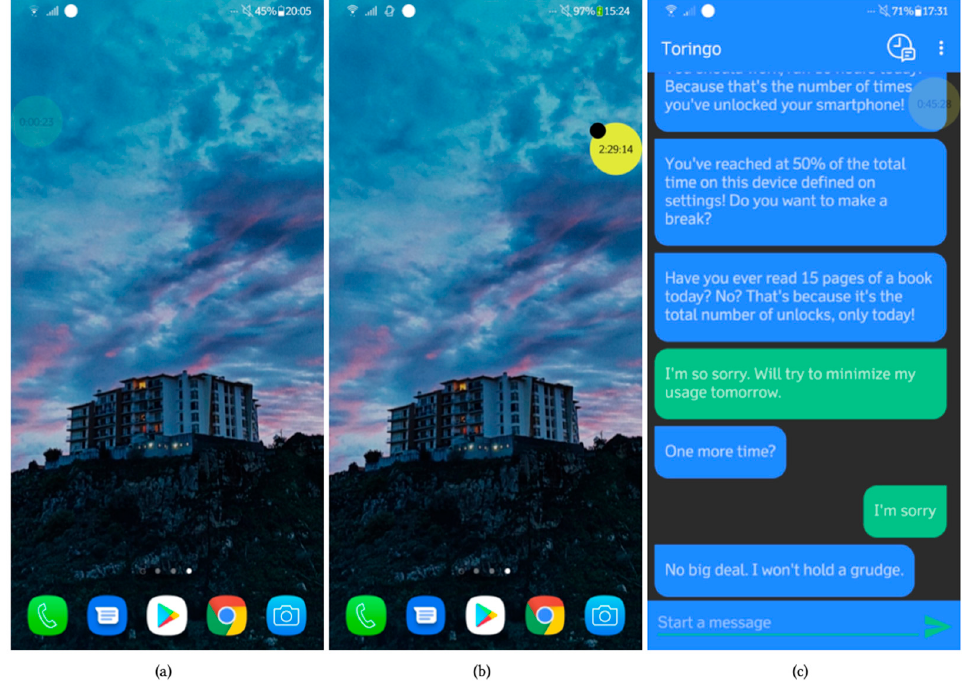
Figure 2. A floating widget that shows the user ( a ) the total time on screen (less than 50% of the defined goal), ( b ) the total time on screen (more than 50% of the defined goal) and with a pending message from the conversational agent, and ( c ) the prototype with answerable messages, triggered by the chatbot.